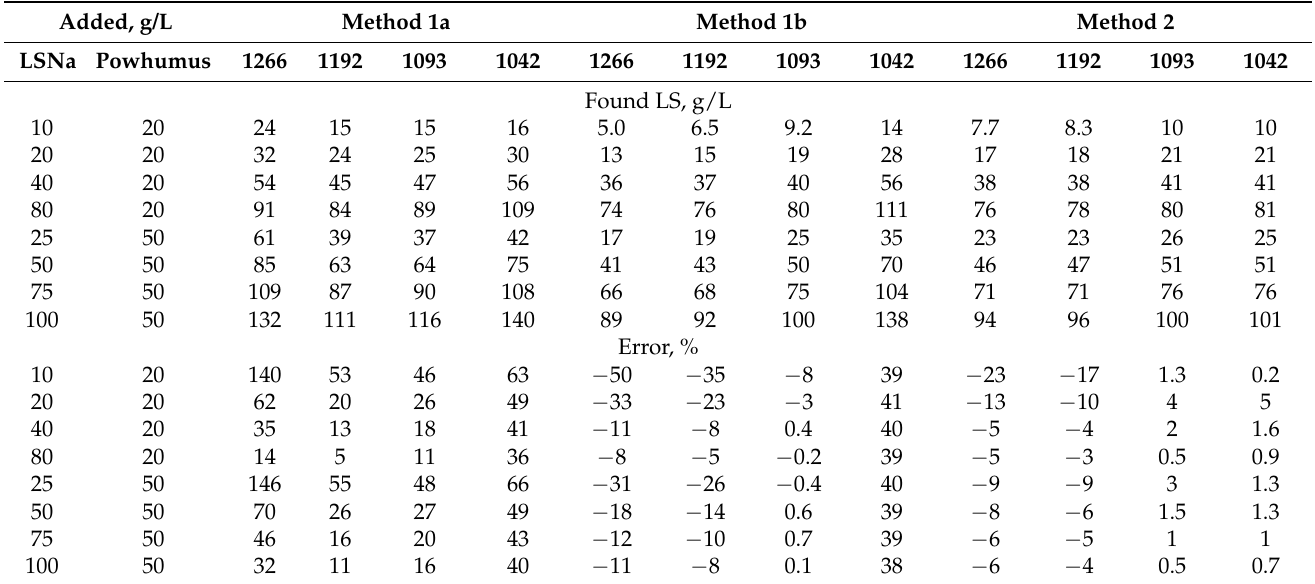
Table 2. Concentrations and the error of lignosulfonate quantification in mixtures with Powhumus humate by the bands at 1266, 1192, 1093, and 1042 cm − 1 by different peak processing methods ( n = 6, p = 0.95).